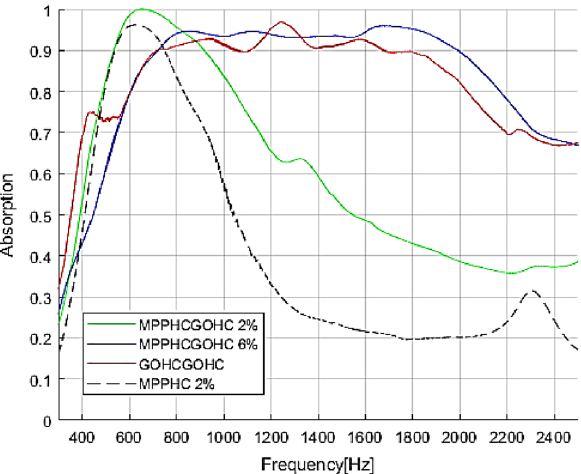
Figure 3. Comparison of GOHCGOHC structure with the MPPHCGOHC structure with different perforation ratio (2% and 6%) and the MPPHC structure. The global thickness of the structures is 50 mm.